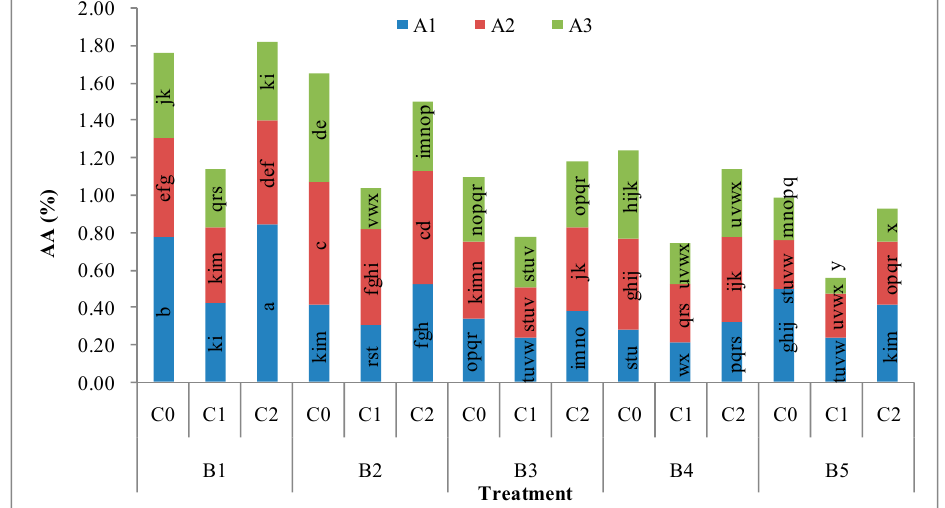
Figure 7. Differences in AA for the interaction between forage species, cutting stage and additive.